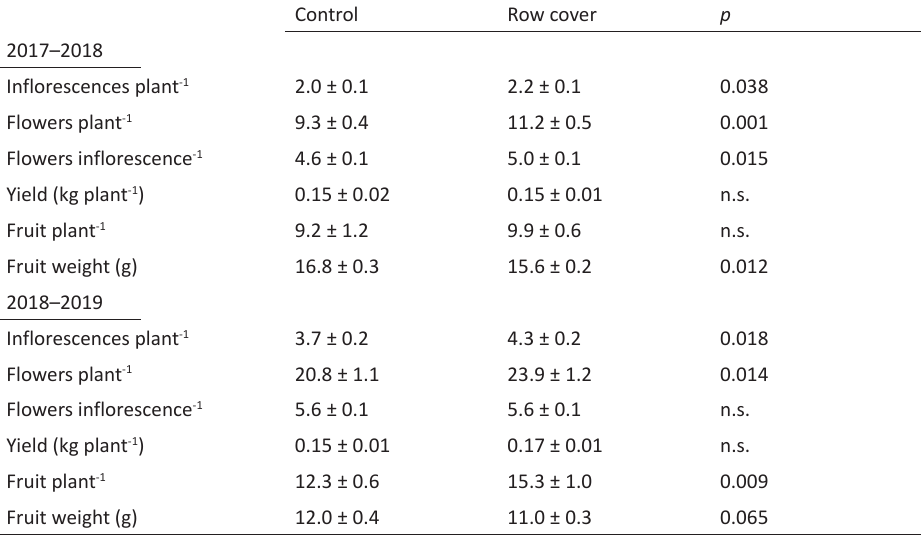
Table 1. Flowering and fruit yield in strawberry cv. Wendy with or without fall row cover installed on 28 followed by ±